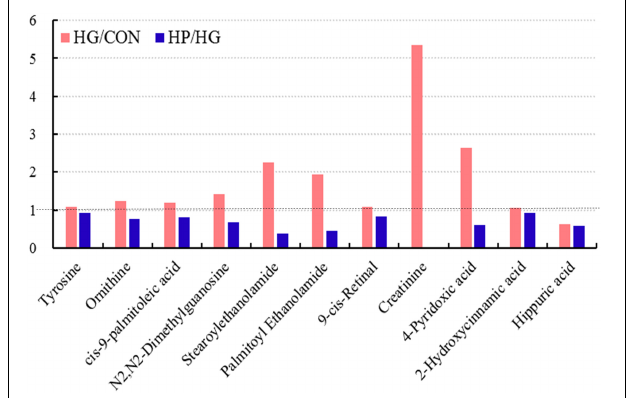
FIGURE 5 | Common differential metabolites in the ileal mucosa of Hu sheep fed CON, HG, and HP